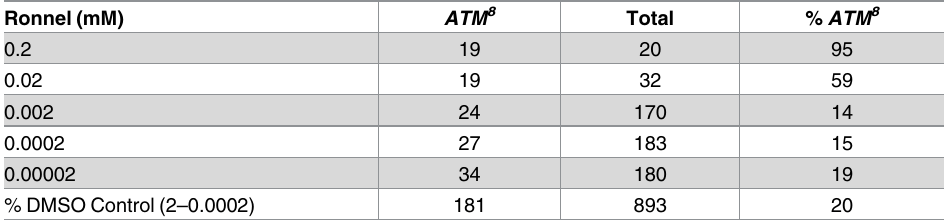
Table 4. Dose-dependent effect of Ronnel on ATM 8